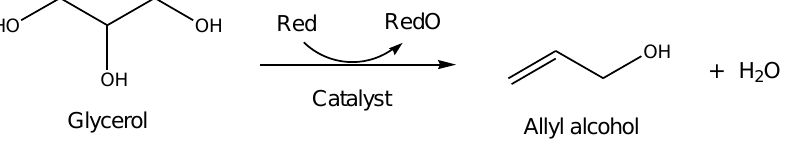
Figure 11. General reaction pathway for the deoxydehydration reaction. Red = reductant. RedO = oxidized reductant [66].